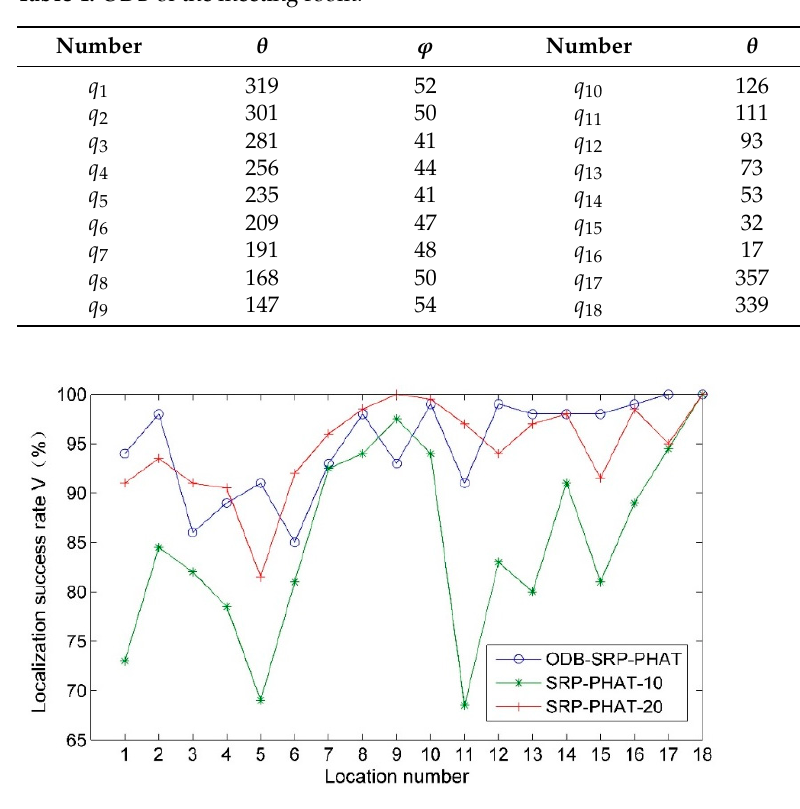
Figure 11. Comparison of the analysis results between SRP-PHAT and ODB-SRP-PHAT.